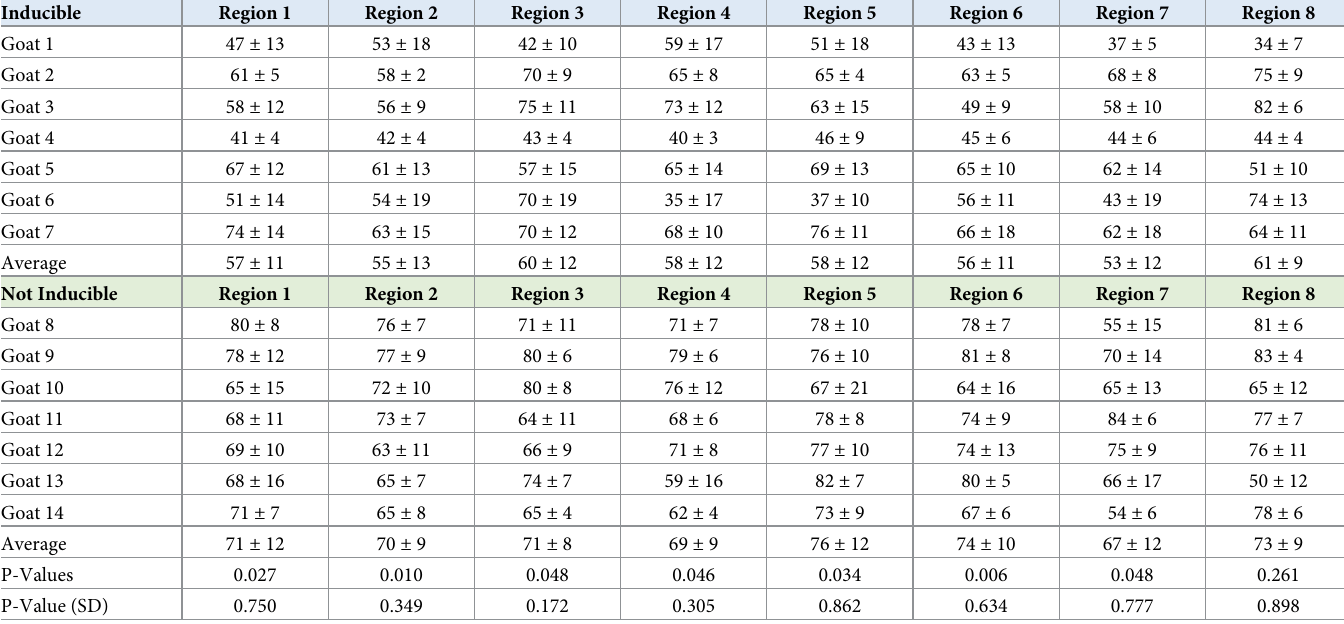
Table 3. Measured average Helix angles in 8 regions with vector 2 chosen as the reference vector for the two AF inducibility based animal groups. P-values showing the difference in the helix angles between the two AF inducibility-based groups in each region are also